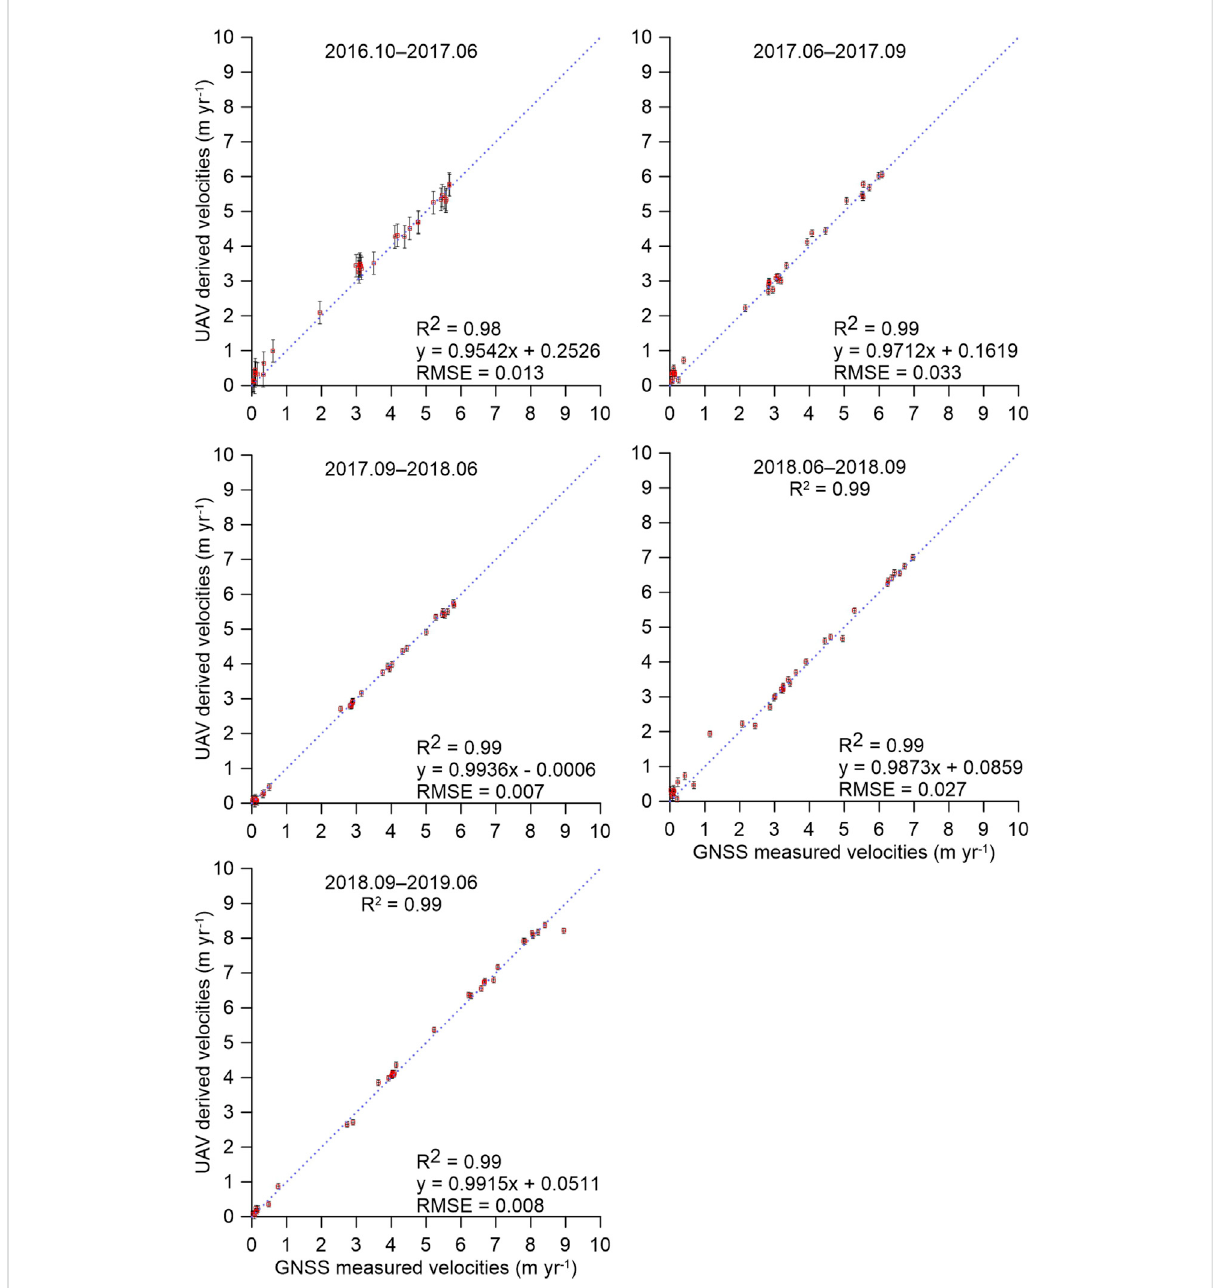
FIGURE 3 Scatterplots of fi ve consecutive periods between velocities derived from UAV analysis and GNSS measurements on 35 kinematic points. The error bars show the calculated uncertainty for UAV-derived and GNSS measured